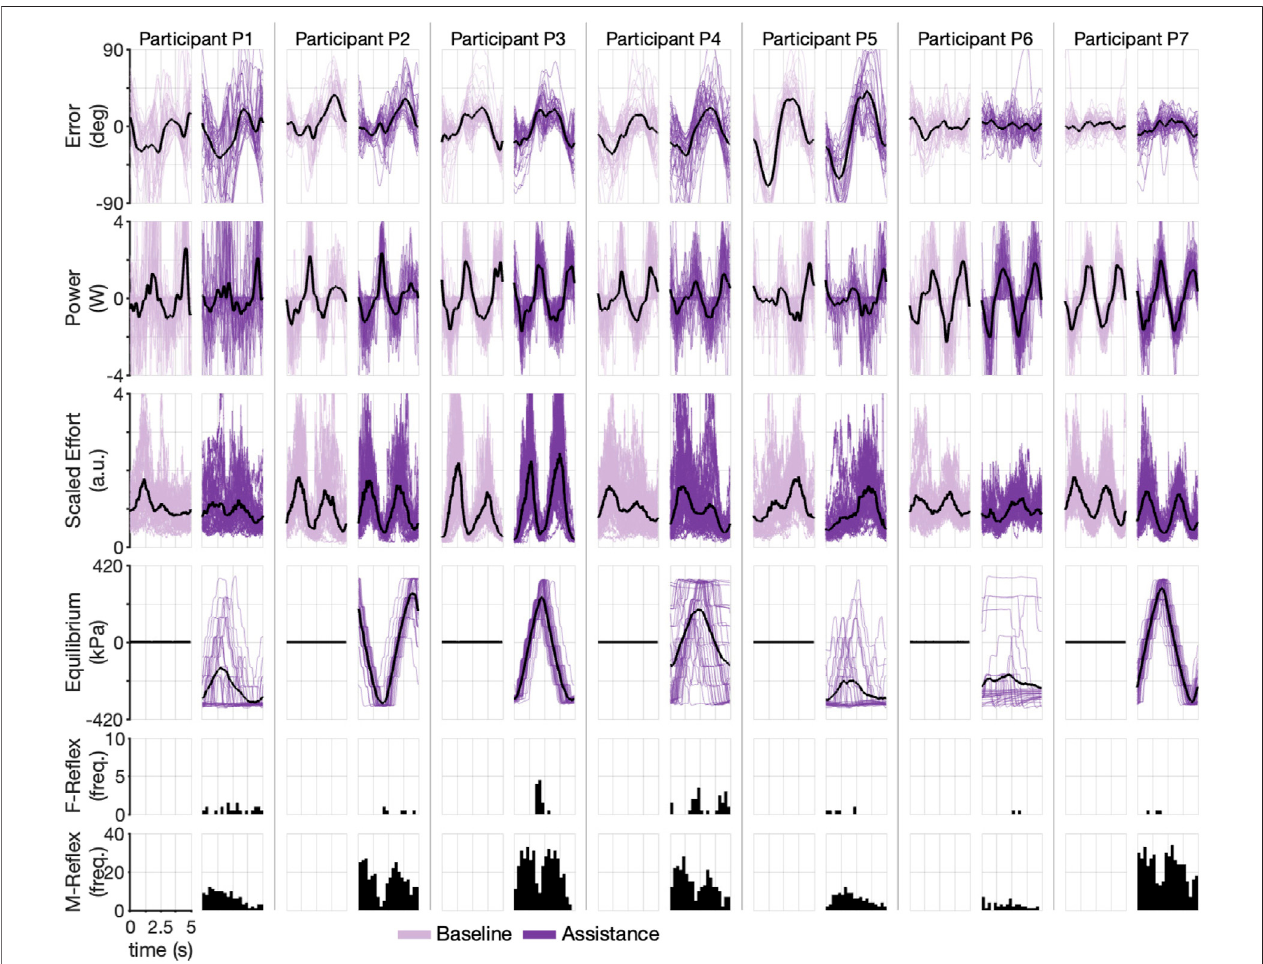
FIGURE 8 | Time-domain experimental results during Stiffness-Dominant environment. Each pair of columns (one for baseline and one for assistance conditions) represents a single participant. Each row shows a different experimental variable. The dark line represents mean. Shaded lines are individual cycles. The last two rows show cycle time histograms (timing of each re fl ex within a cycle) of each type of triggered re fl ex (F-Re fl ex, M-Re fl ex).